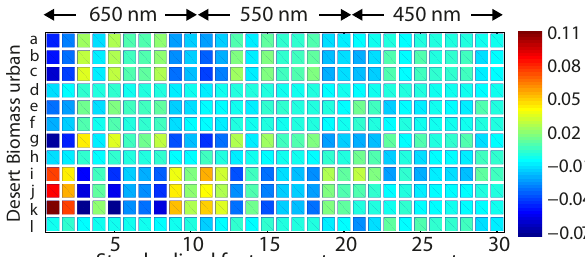
Fig. 5. Standardized feature vector space for representative aerosol components: Rows correspond to FVs for the 12 aerosols (a–l) as specified in Table 1. FV-components 1–10 correspond to 650nm, components 11–20 to 550nm and 21–30 to 450nm. Standardization is such that the mean of each column is